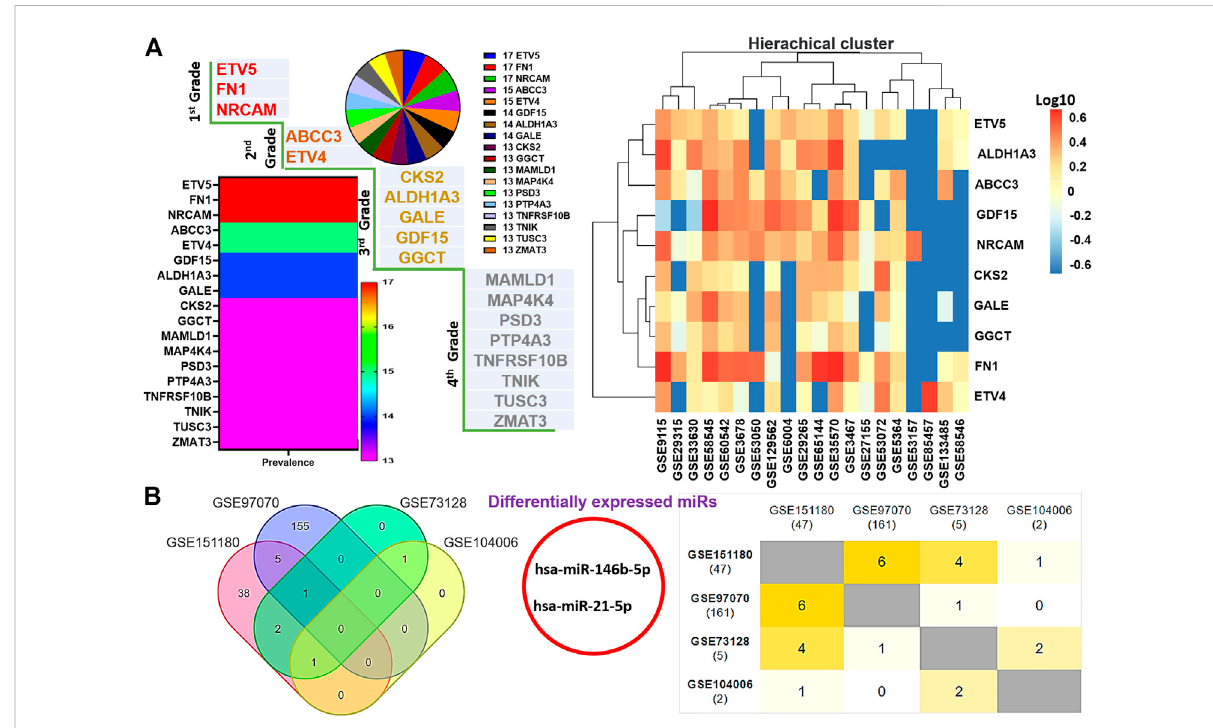
FIGURE 2 Large-scale transcriptomic data analysis identi fi ed graded levels of biomarker signatures of thyroid cancer pathogenesis. (A) Multiplot and hierarchicalclusteringofdifferentiallyexpressedgenes(DEGs)identi fi edfromthelarge-scaletranscriptomicdatasets. (B) VenndiagramandJaccard plot of the differentially expressed microRNAs identi fi ed from the integrations of DEmiRs in THCA datasets.